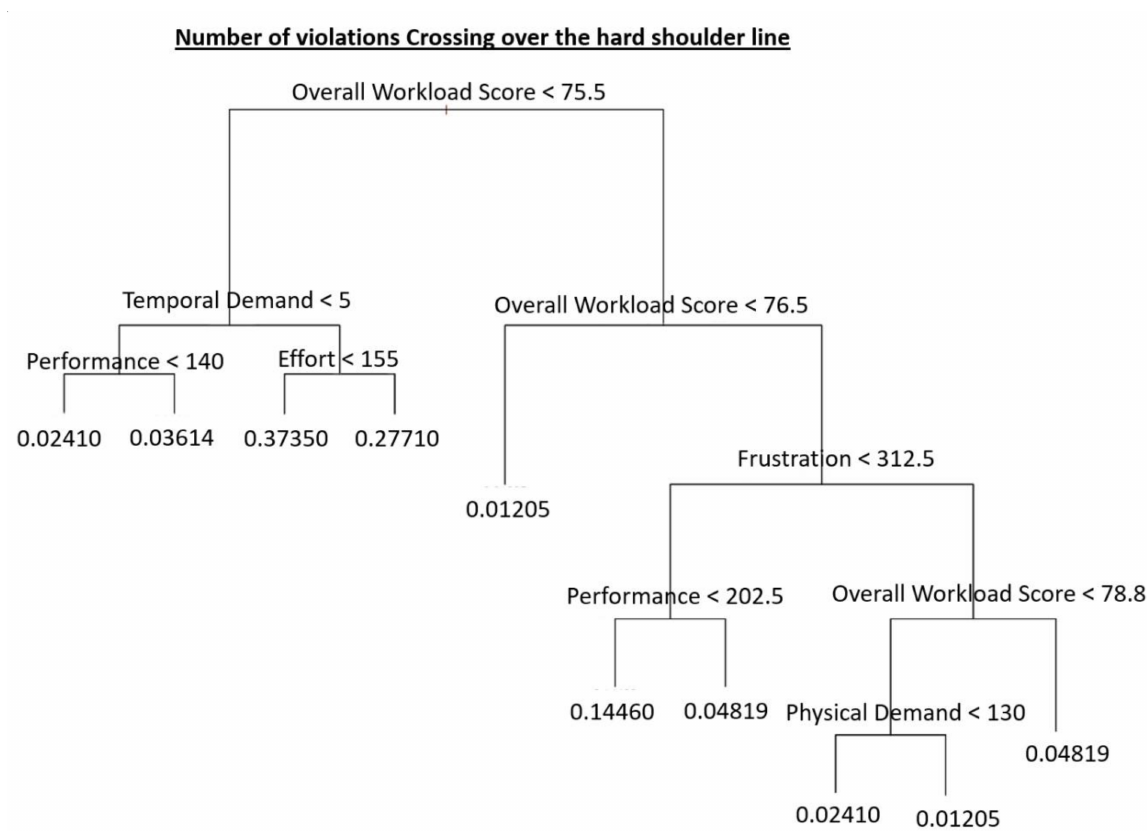
Figure 5. The Regression tree related to crossing over the hard shoulder line violations.